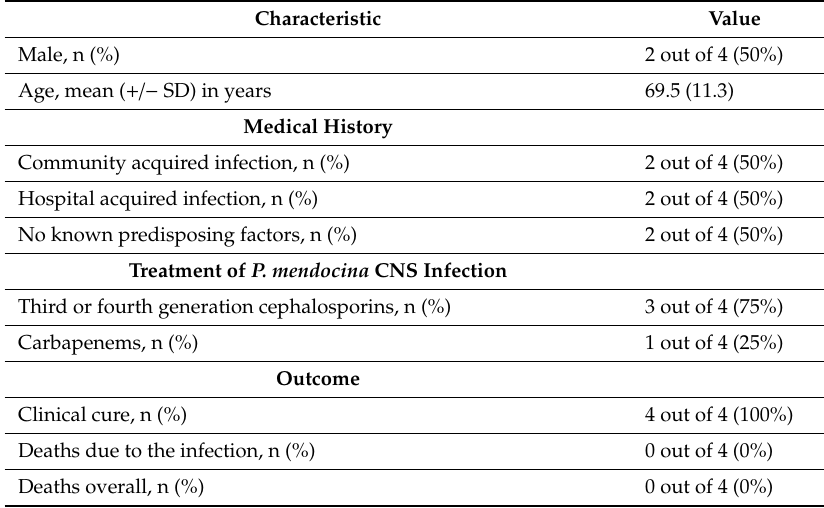
Table 3. Characteristics of four patients with central nervous system infections by Pseudomonas mendocina : treatment and outcomes. Values show cases among patients with available